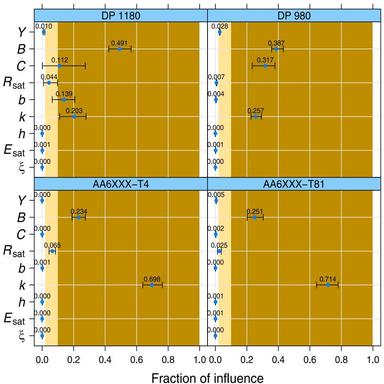
Global sensitivity analysis (GSA). Average (points) and range (bars) for the fraction of influence of each Y-U parameter determined using the Optimization Method. Shading in the body of the plot denotes region of large (dark shading), small (light shading), and no (no shading) influence. Numerical values of the fraction of influence are plotted above the symbol.